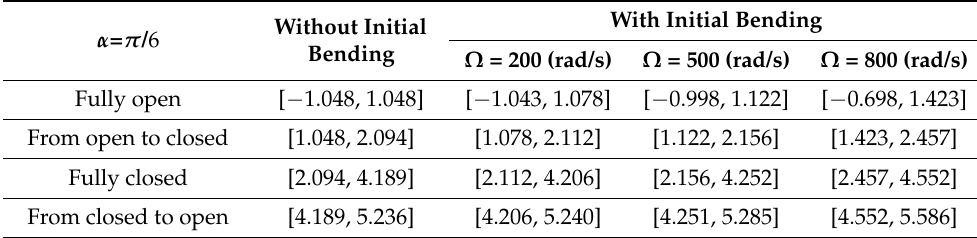
Table 2. Comparison of the region sizes of each crack